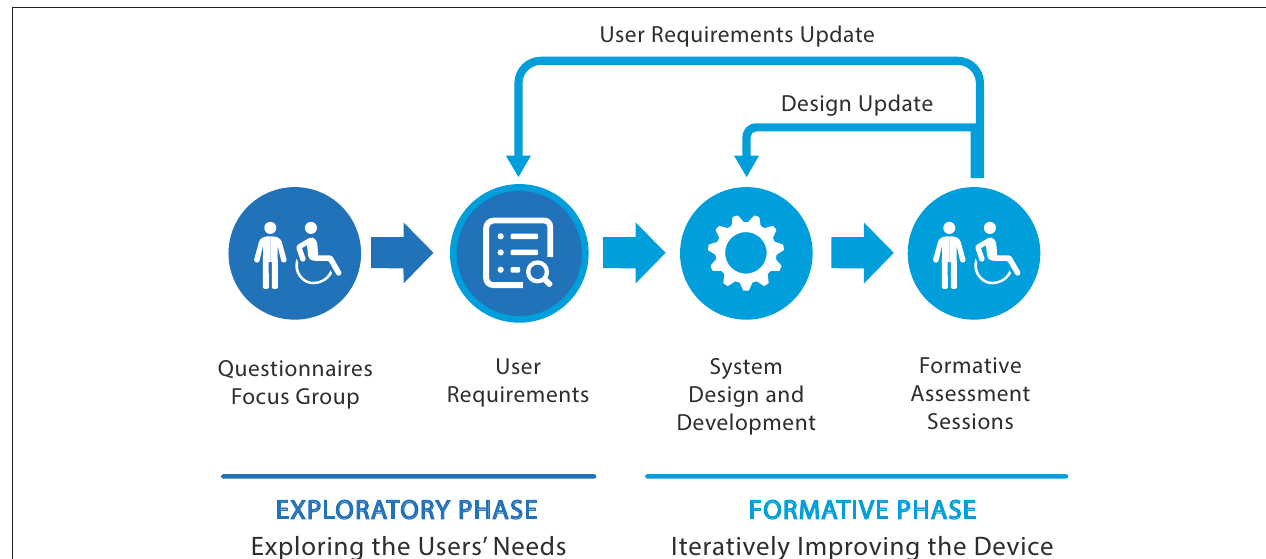
FIGURE 1 | The design process employed in TWIN consisted of two main stages: the exploratory and formative phases, which directly involved users and the stakeholders.